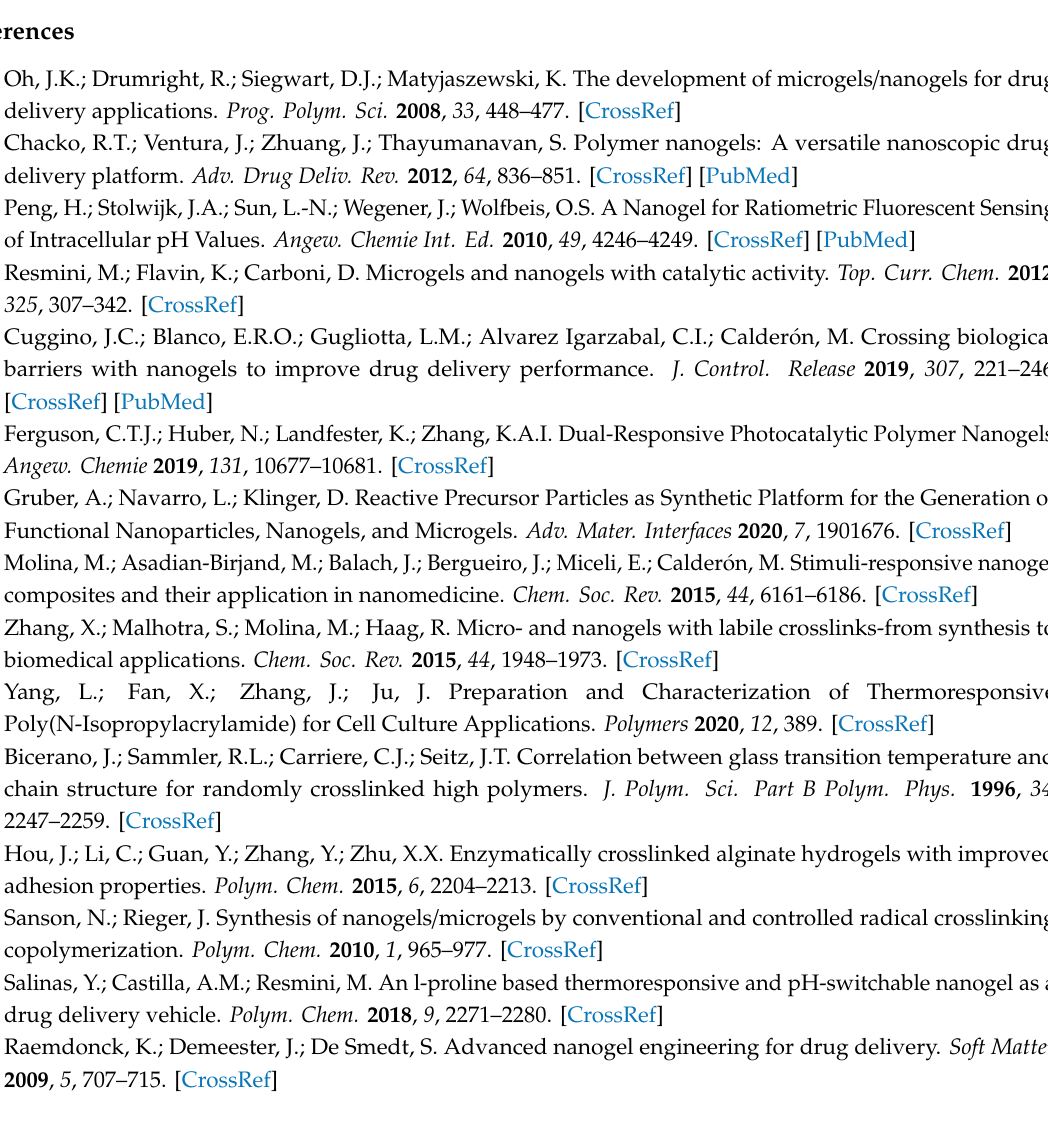
Table S1. Bu ff er recipes and calculations of ionic strength; Table S2. VPTT values of NG1–NG9 in di ff erent media; Table S3: Recipes for TAB and NaCl solutions preparation with the same ionic strength; Table S4: VPTT values of NG7 and NG10 in TAB bu ff er with the addition of NaCl; Figure S1. Dynamic light scattering of nanogels NG1–NG3 in di ff erent media at 20 ◦ C; Figure S2. Dynamic light scattering of nanogels NG4–NG6 in di ff erent media at 20 ◦ C; Figure S3. Dynamic light scattering of nanogels NG7-NG9 in di ff erent media at 20 ◦ C; Figure S4. Dynamic light scattering of nanogels N7 and N10 in TAB but di ff erent pH values; Figure S5. Gaussian fitting (solid lines) of the 1st derivate of VPTT profiles for NG1–NG3 in di ff erent media; Figure S6. Gaussian fitting (solid lines) of the 1st derivate of VPTT profiles for NG4–NG6 in di ff erent media; Figure S7. Gaussian fitting (solid lines) of the 1st derivate of VPTT profiles for NG7–NG9 in di ff erent media; Figure S8. Gaussian fitting (solid lines) of the 1st derivate of VPTT profiles for NG7 and NG10 in di ff erent pH TAB solution with the addition of